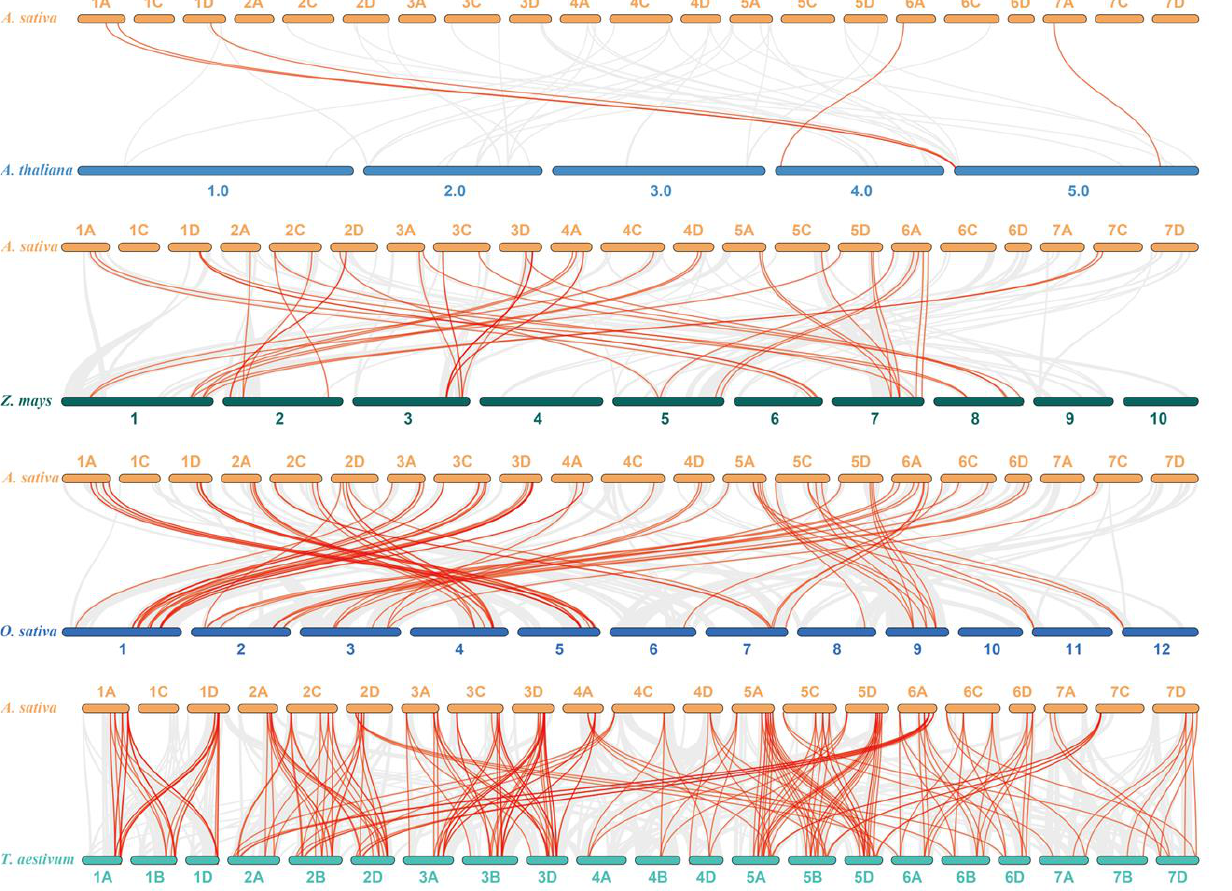
Figure 6. Synteny analysis of AsWRKY genes between oat and five representative plant species. The gray lines show colinear blocks in the genomes of oat with other plants, while the red line highlights the colinear WRKY pairs. The species name with the prefixes ‘ A. sativa ’, ‘ A. thaliana ’, ‘ Z. mays ’, ‘ O. sativa ’ and ‘ T. aestivum ’ indicate Avena sativa , Arabidopsis thaliana , Zea mays , Oryza sativa , and Triticum aestivum , respectively.